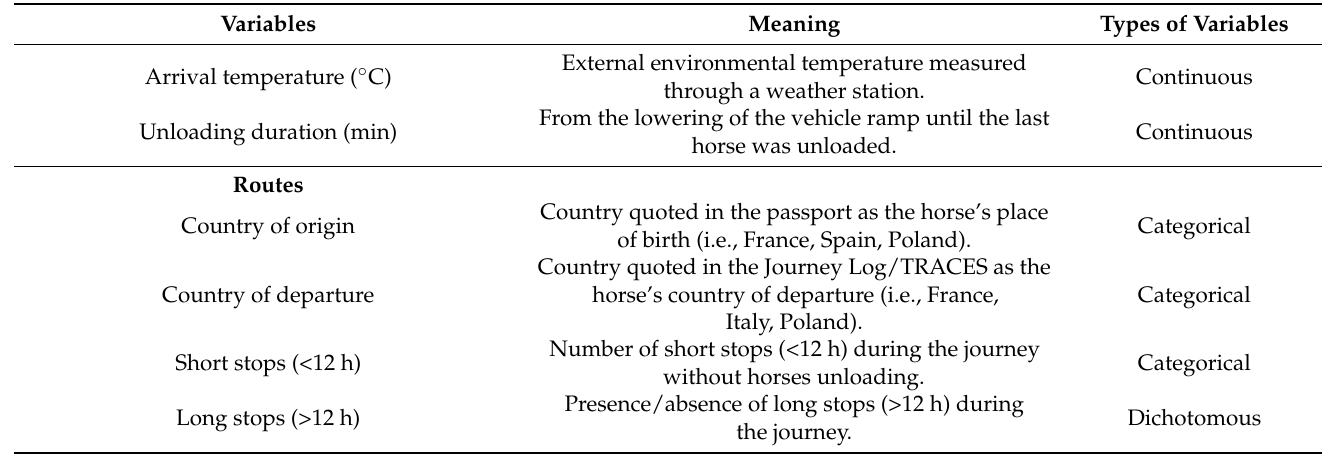
Table 5. Definition and type of the variables obtained for the present